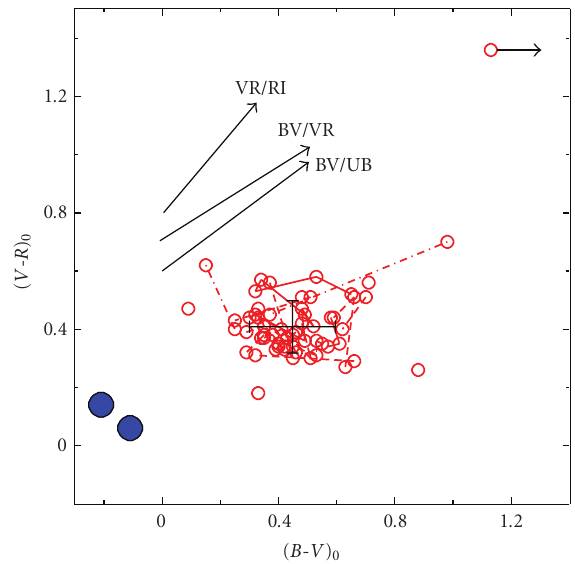
is used for rest